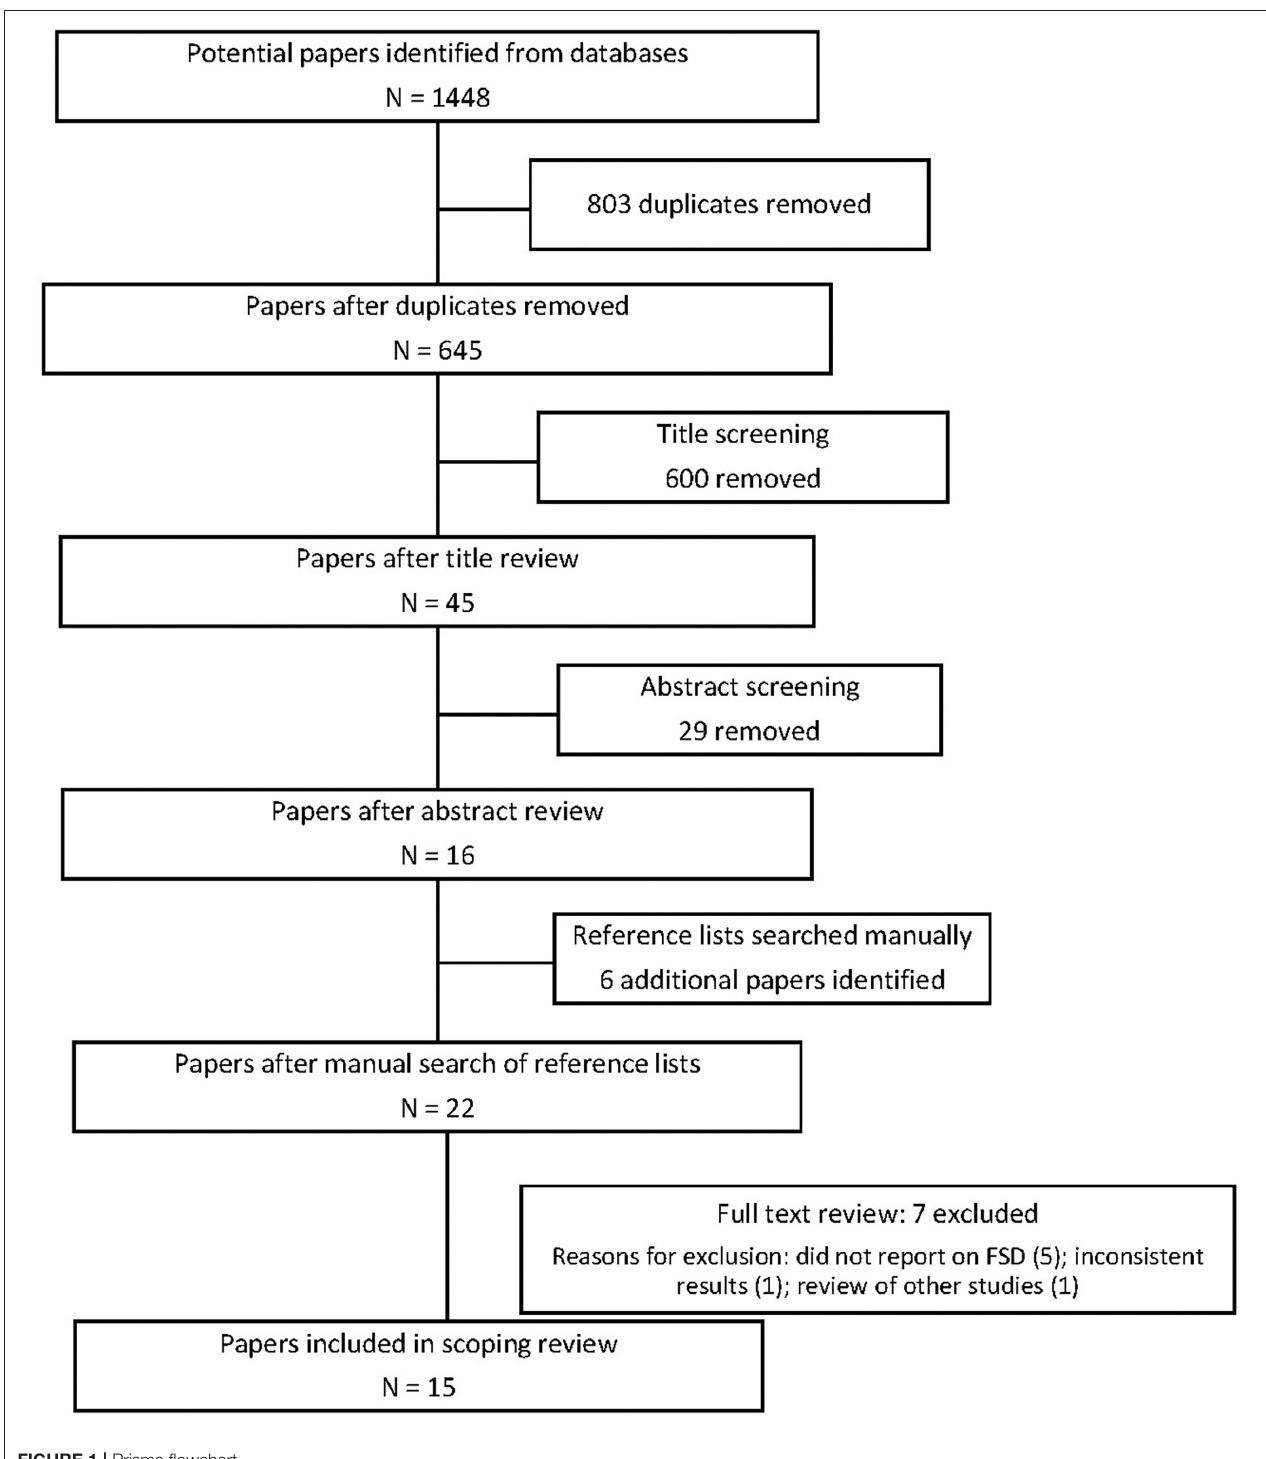
FIGURE 1 | Prisma